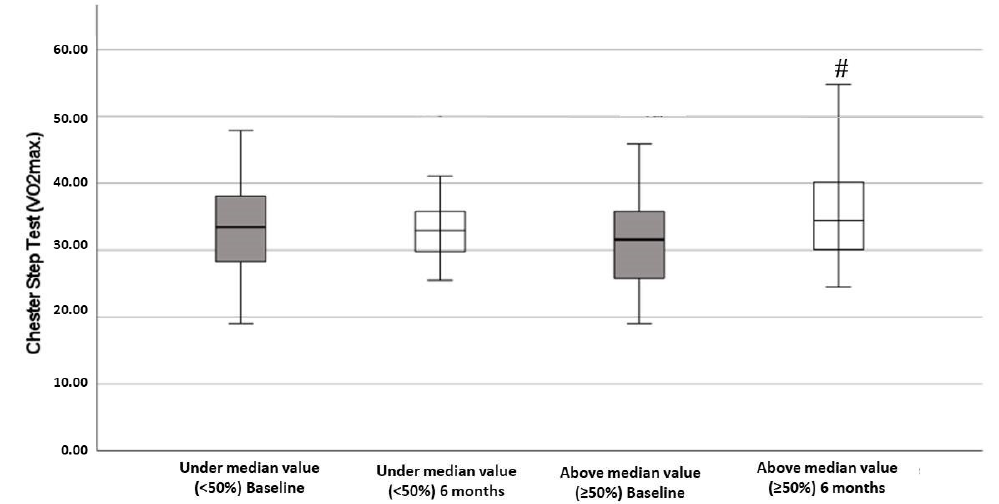
Figure 2. Chester step test (VO 2 max.) of patients in this study, classified according to adherence to Mediterranean diet. Significant improvement of Chester step test was found after 6-month follow- up in above median value group ( ≥ 50%). Statistics: Two-way ANOVA. Results are presented as mean ± SEM. # Difference in means between time.